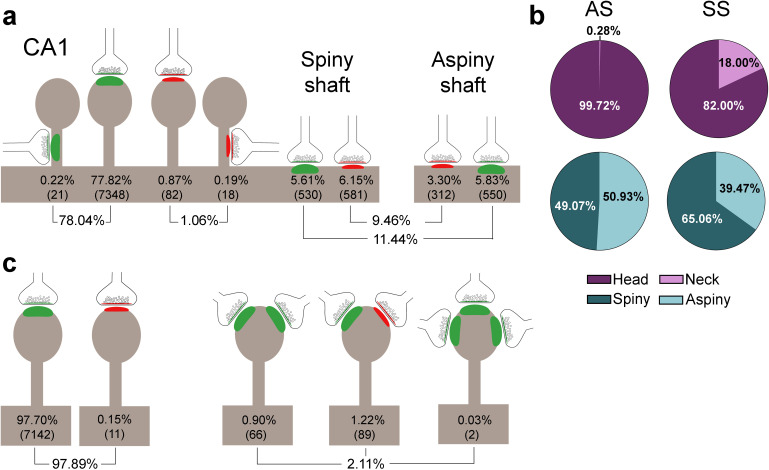
Schematic representation of the distribution of synapses regarding postsynaptic targets and dendritic spines in the whole CA1.(a) Frequency of axospinous synapses (both on the head and neck of dendritic spines) and axodendritic synapses (both on spiny and aspiny shafts) for asymmetric synapses (AS; green) and symmetric synapses (SS; red). Percentage and number of each synaptic type (below in brackets) are shown. (b) Proportions of the exact location of axospinous synapses (i.e., the head or neck of the spine) and axodendritic synapses (i.e., spiny or aspiny shafts) in both AS and SS, represented as pie charts. (c) Percentage of dendritic spines receiving single or multiple synaptic contacts. AS: asymmetric synapse; SS: symmetric synapse.